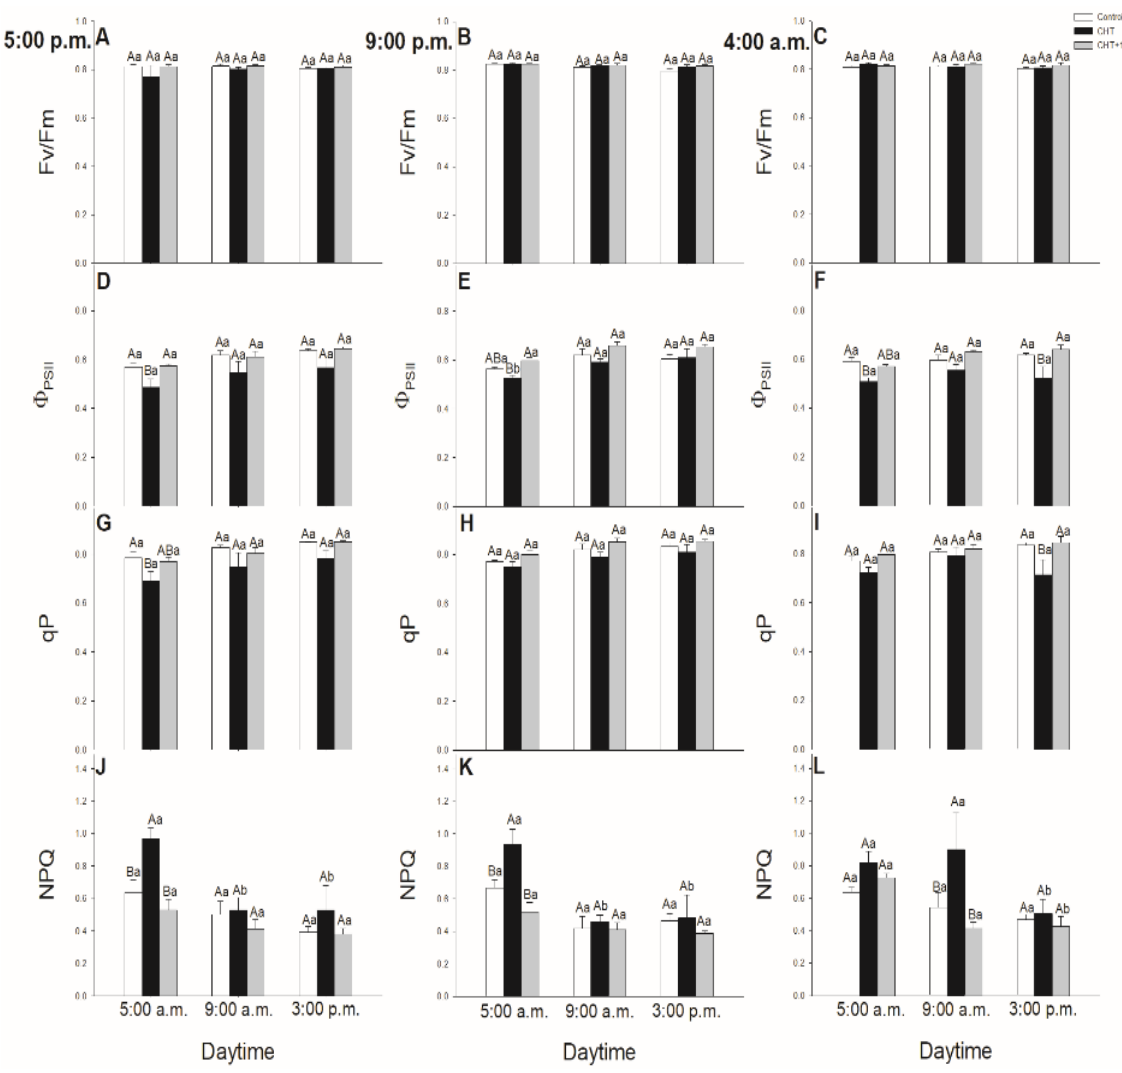
Figure 7. Changes in the chlorophyll a fluorescence parameters Fv / Fm ( A – C ), Φ PSII ( D – F ), qP ( G – I ), NPQ ( J – L ) of leaves of intact tomato plants treated foliar with 100 µ g mL –1 chitosan (CHT) dissolved in the experimental bu ff er (1 mM AA, 10 mM MES / TRIS, 10 mM KCl, 0.1 mM CaCl 2 , pH 6.15) at di ff erent daytimes: at the end of light cycle (17:00 hrs), at night (21:00 hrs), at dawn (04:00 hrs). Measurements were disposed at constant times after treatments (05:00, 09:00, and 15:00 hrs). Means ± SE, n = 3. Means were analyzed by two-way ANOVA, significant di ff erences among the data were analyzed by Holm–Sidak test. Mean values significantly di ff erent at P < 0.05 were signed with di ff erent letters, upper case letters indicate the e ff ects of the treatment at the same daytime, and lower case letters indicate the e ff ects of the daytime under the same treatment. (Control: treatment with 1 mM Acetic acid bu ff er (AA); CHT: treatment with 100 µ g mL –1 chitosan in experimental bu ff er containing AA; CHT + 1: untreated distal leaf level from the CHT-treated